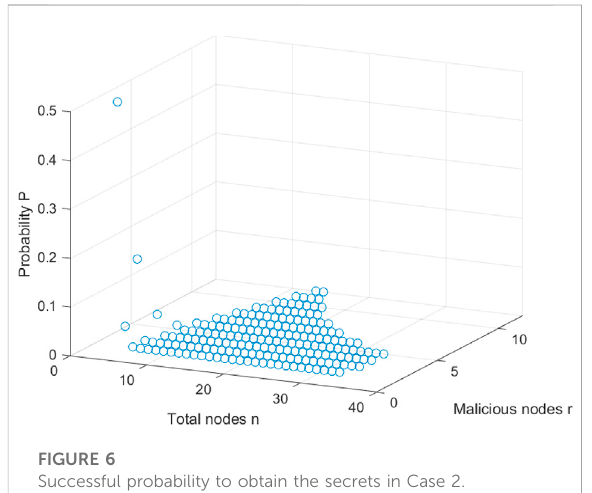
FIGURE 7 Successful probability to obtain the secrets in Case